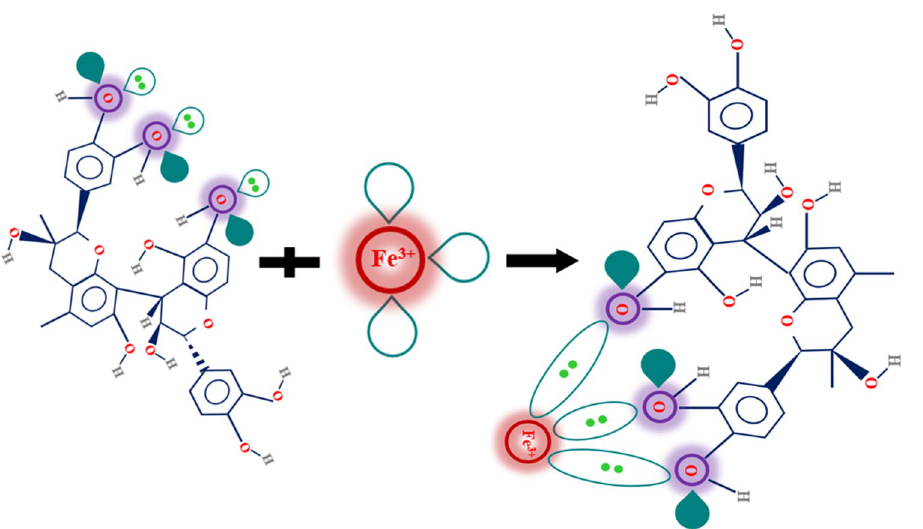
Figure 16. Schematic of complex formation of Fe cation and